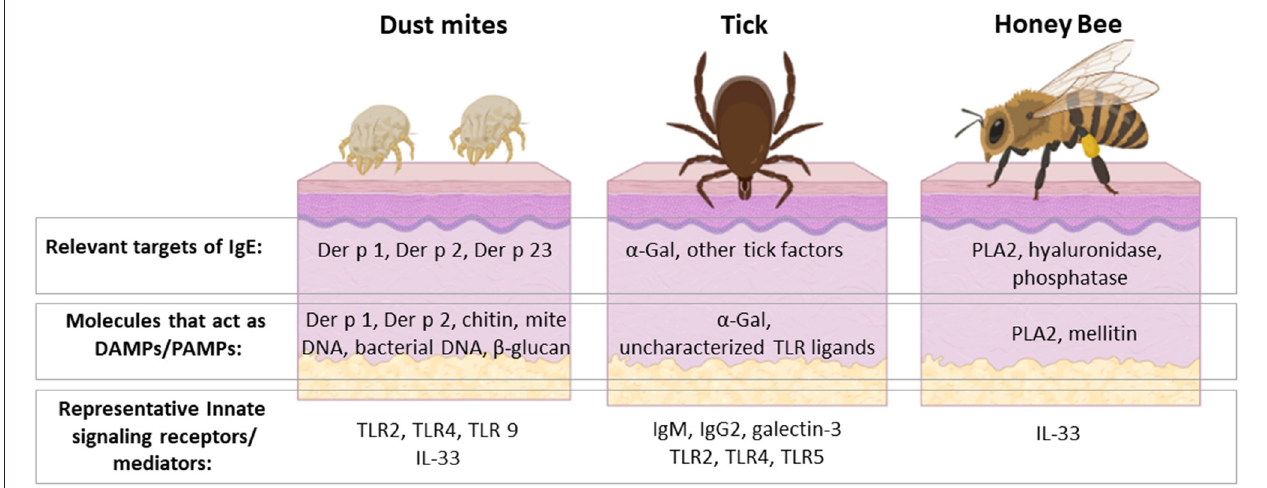
FIGURE 3 | HDM, ticks and venomous insects are important causes of allergic disease with several shared features but also important differences. They are all members of the Arthropod phylum and can interact with the host at the skin barrier, though HDM sensitization occurs dominantly via the respiratory mucosa. The major allergens of HDM, ticks and honey bee are unique from each other, but share the distinction of acting to stimulate host innate immunity. Some allergens, such as Der p 2 and α -Gal, are recognized directly by innate immune receptors. Other allergens, such as Der p 1 and PLA 2, have enzymatic activity that leads to activation of innate mediators, including IL-33. Activation of these innate pathways is incompletely understood but leads to induction of Th2 cells and IgE class-switch. Rhinitis, asthma, and anaphylaxis are allergic sequelae that can occur upon re-exposure to the relevant arthropod. On the other hand, these symptoms are manifestations relating to allergic host defenses that have evolved to defend against these organisms. Created with